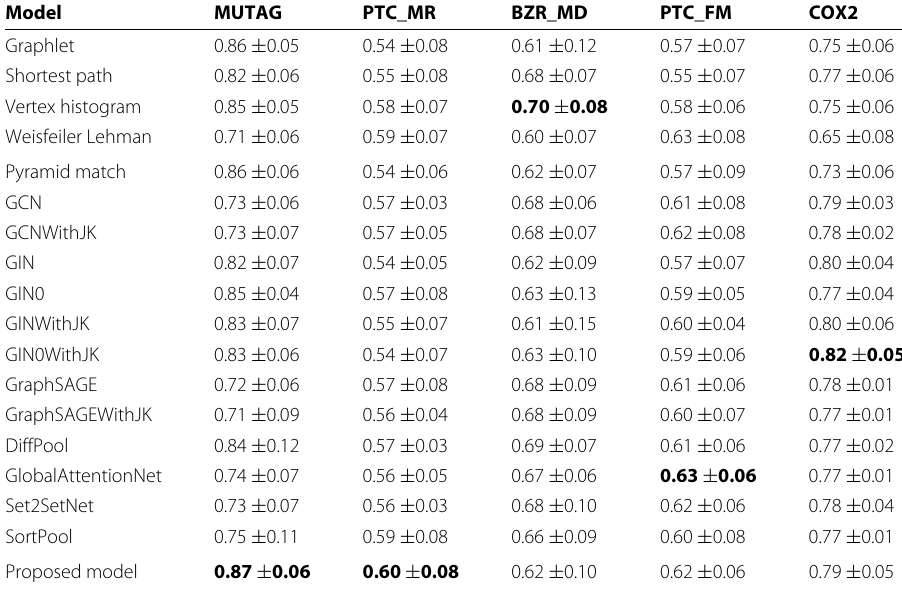
Table 2 For each dataset, the mean classification accuracy plus standard deviation of 10-fold cross validation for each graph classification model are displayed Model